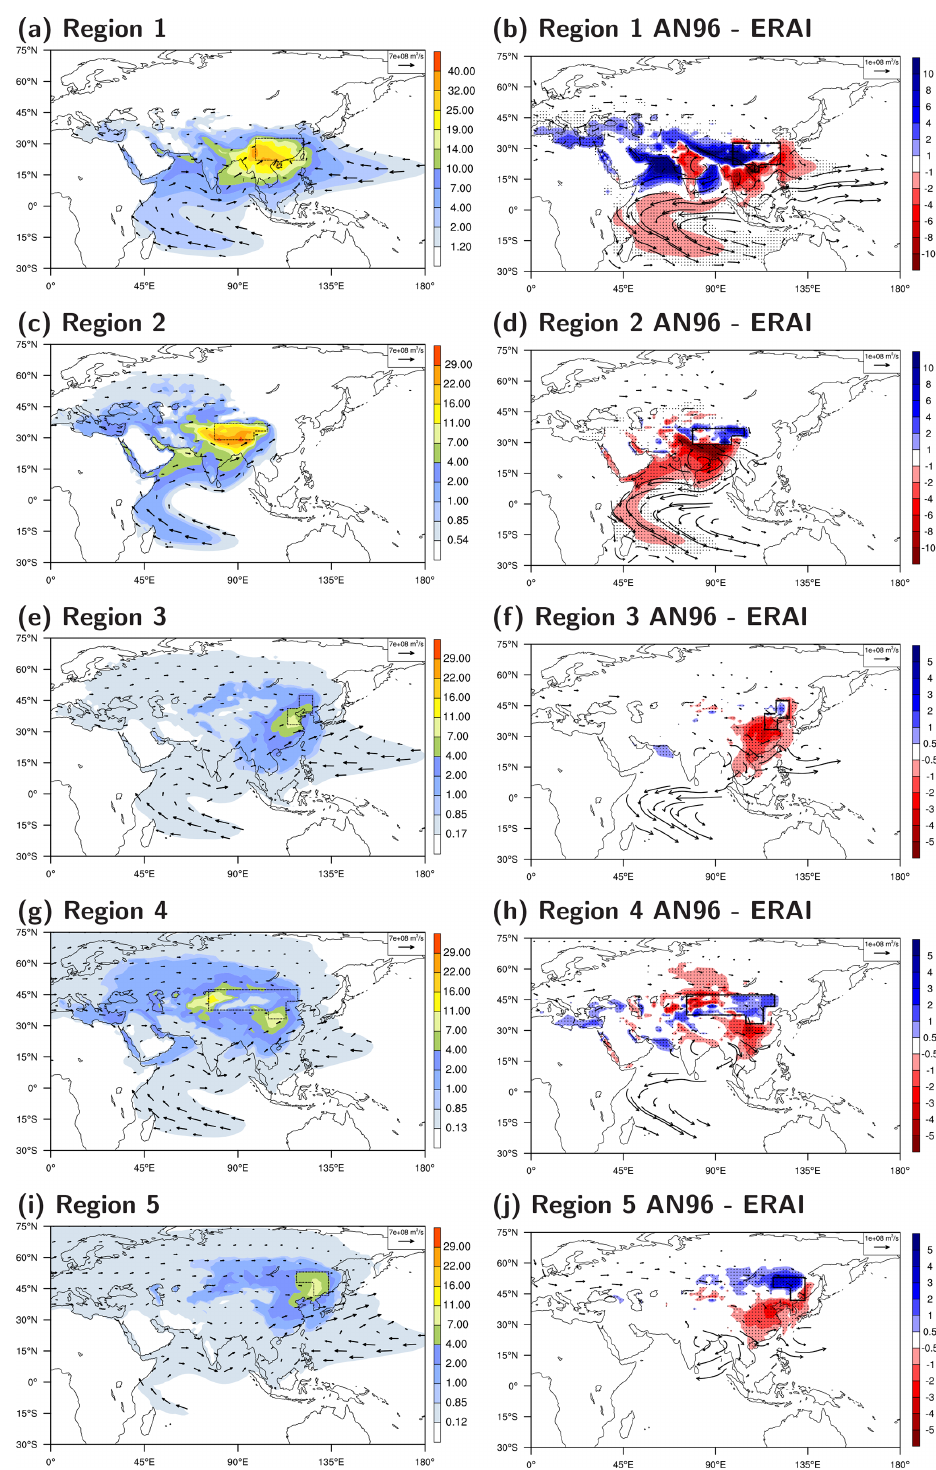
Figure 4. Annual mean moisture source for EA subregions ( a , c , e , g and i ; units: mmpermonth) and vertically integrated moisture flux (vector; units: m 3 s − 1 ) calculated from ERA-Interim. Moisture source accounts for 80% of precipitation are shown. Difference in annual mean moisture sources between AN96 and ERA-Interim ( b , d , f , h and j ; units: mmpermonth). The black box in each panel indicates the target